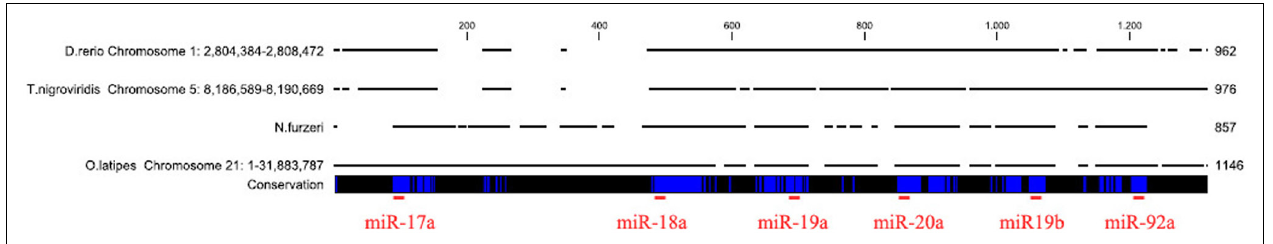
FIGURE 1 |Alignment of the microRNA cluster 17–92 from the four teleost species. The genomic regions of D. rerio , T. nigroviridis , and O. latipes were aligned to the fragment amplified in N. furzeri .The blue vertical bars indicate identical nucleotides.The localization of the mature miRNA sequences is indicated by a red horizontal